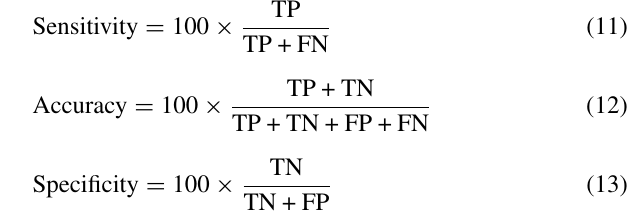
the measure of targets that have been appropriately recog- nized (True positive rate or Recall). Accuracy is employed as the assessment metric for computing the overlap between the ground truths and the estimated targets [9, 13, 48]. These three criteria are computed